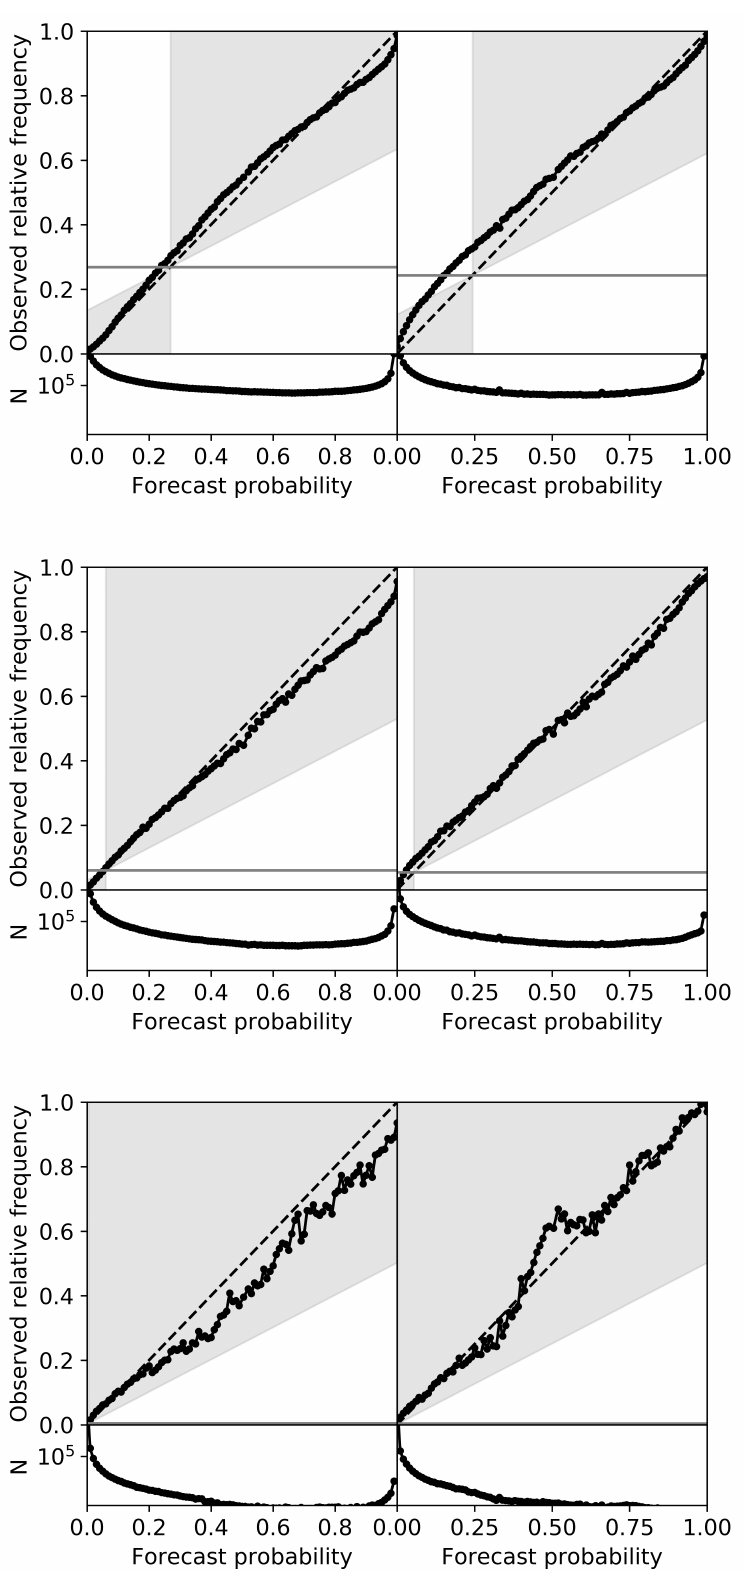
Figure 12. Reliability diagram for NN (to the right) and STEPS (to the left), for exceeding precipitation thresholds of: 1mm/hr (fisrt row), 5 mm/hr (second row) and 20mm/hr (third row).